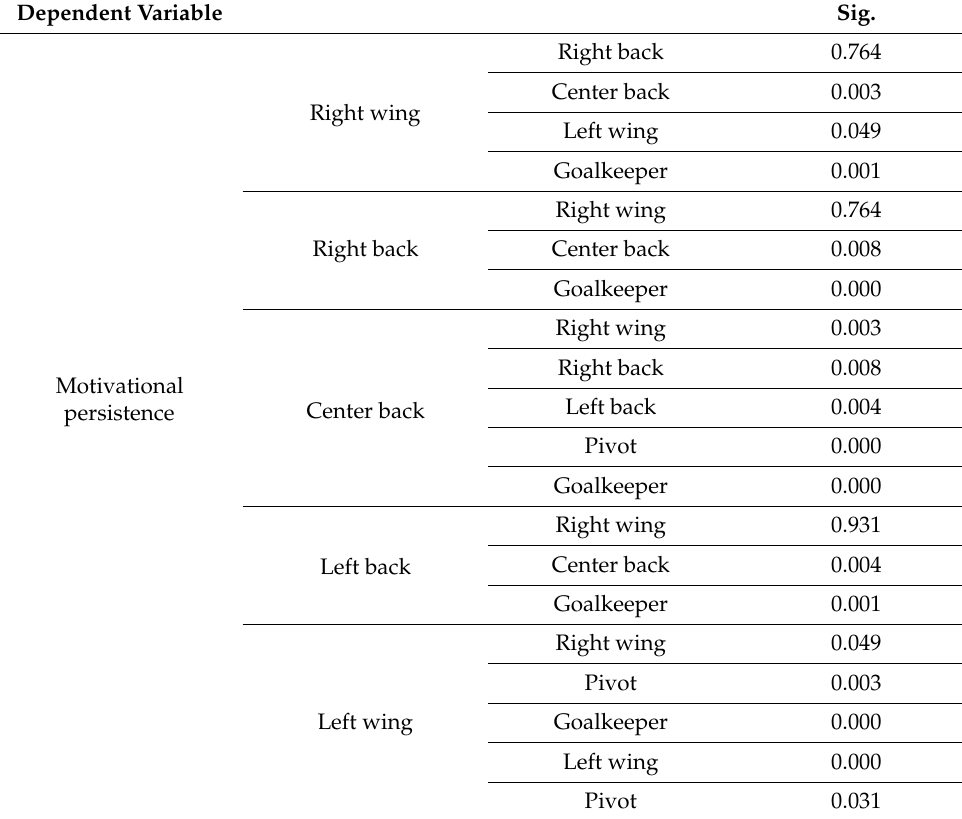
Table 3. Post hoc analysis. Statistically significant means of the psychological characteristics. Dependent